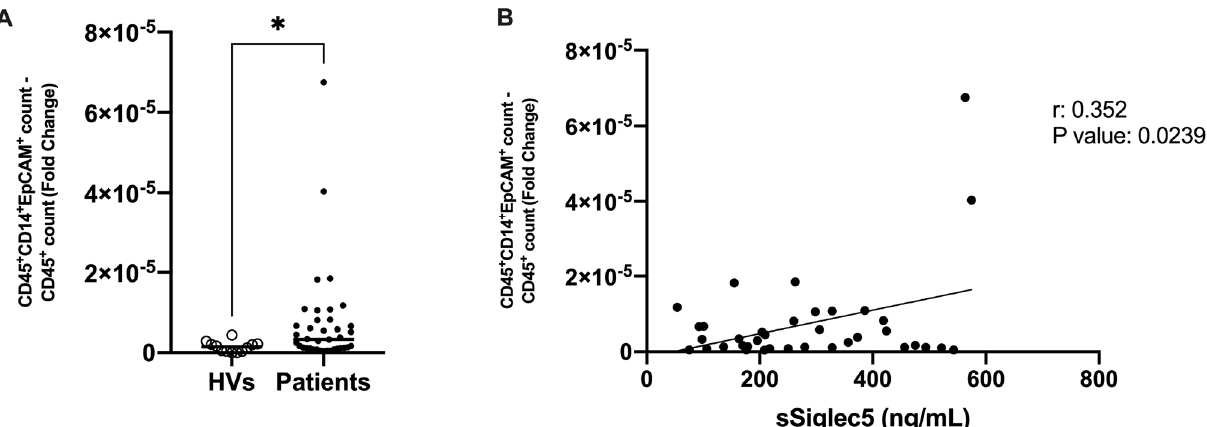
Figure 9. THC counts and soluble SIGLEC5 in circulation of CRC patients. ( A ) Normalised count of THCs (CD45 + CD14 + EpCAM + ) with respect to total numbers of CD45 + cells in whole blood samples of CRC patients (prospective cohort, Table 2) (black; n = 38) and HVs (clear; n = 12). ( B ) Correlation between normalised THC counts and plasma sSIGLEC5 levels in patients with colorectal cancer is shown. The correlation between normalised THC counts and sSIGLEC5 was analysed by Pearson’s r. Simple correlations of every stage were performed with 95% confidence intervals. *, p < 0.05.